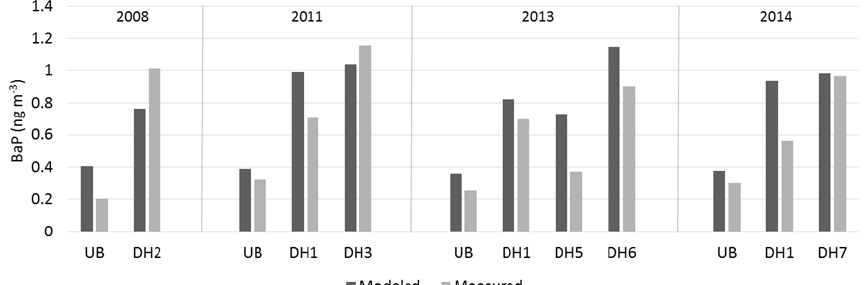
Figure 7. Comparison of predicted and observed annual average BaP concentrations at different sites in the Helsinki metropolitan area in 2008, 2011, 2013, and